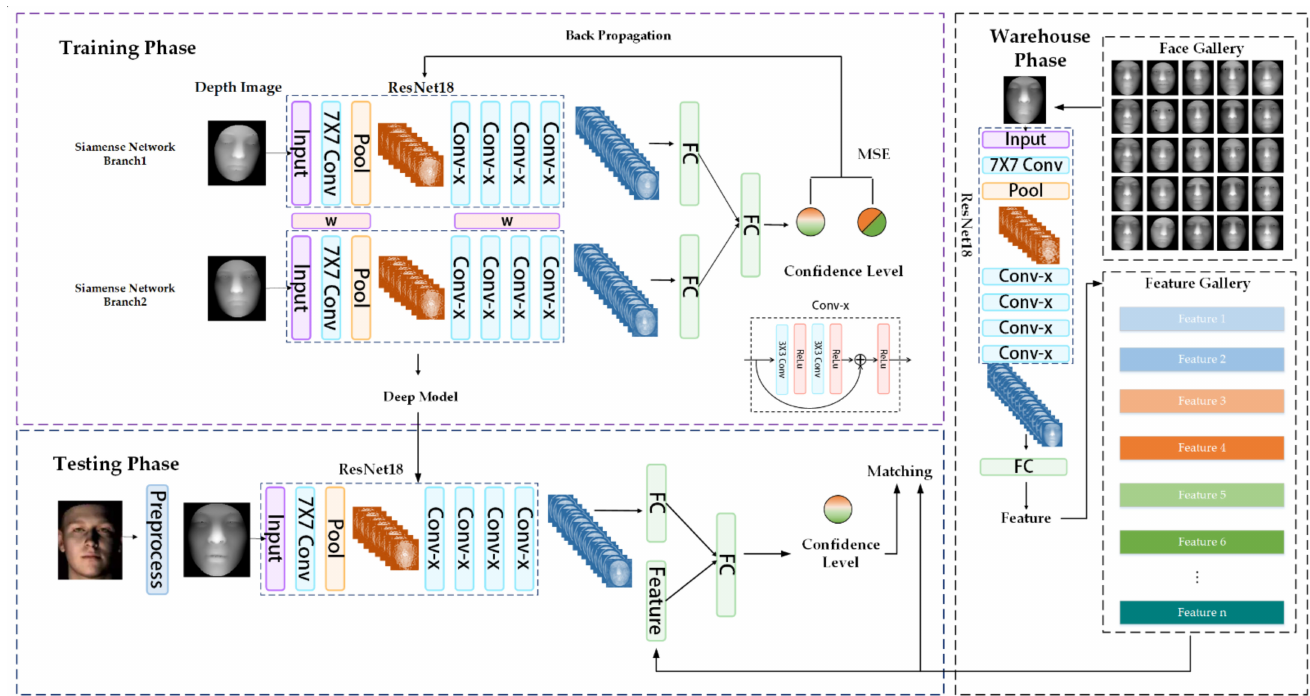
Figure 3. Overview of the proposed 3D face recognition